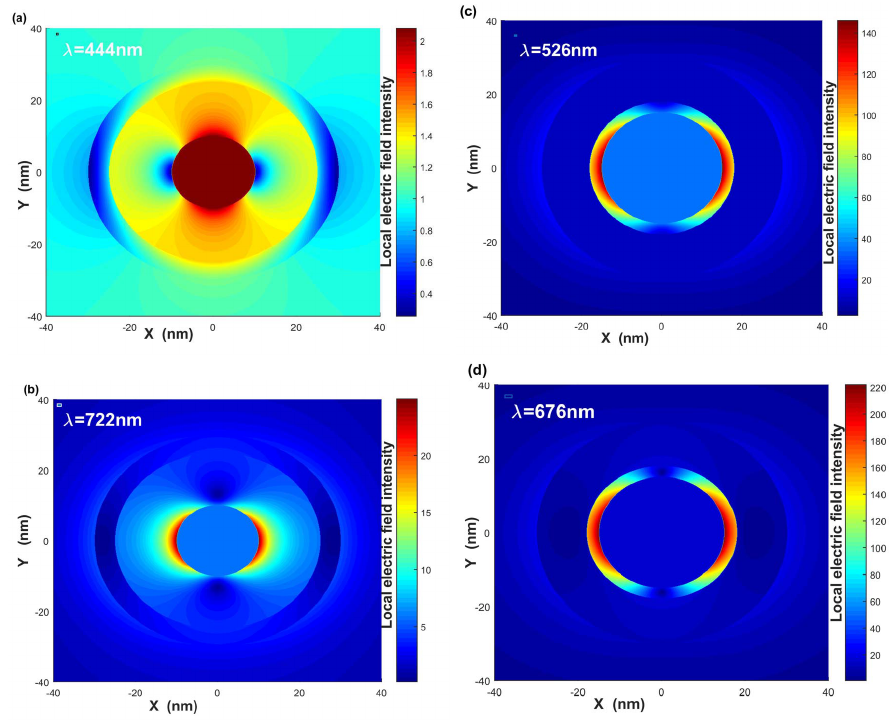
Figure 7. Local electric field intensity distributions of gold–dielectric–silver nanoshell with each LSPR wavelength. ( a , b ) [ r 1 , r 2 , r 3 ] = [10 nm, 15 nm, 20 nm], [ ε 2 , ε 4 ] = [ 4.0,2.0 ] , and the local surface plasmon resonance wavelengths are at λ = 444 nm and λ = 722 nm, respectively. ( c , d ) [ r 1 , r 2 , r 3 ] = [15 nm, 18 nm, 30 nm], [ ε 2 , ε 4 ] = [ 1.0,5.0 ] , and the local surface plasmon resonance wavelengths are at λ = 526 nm and λ = 676